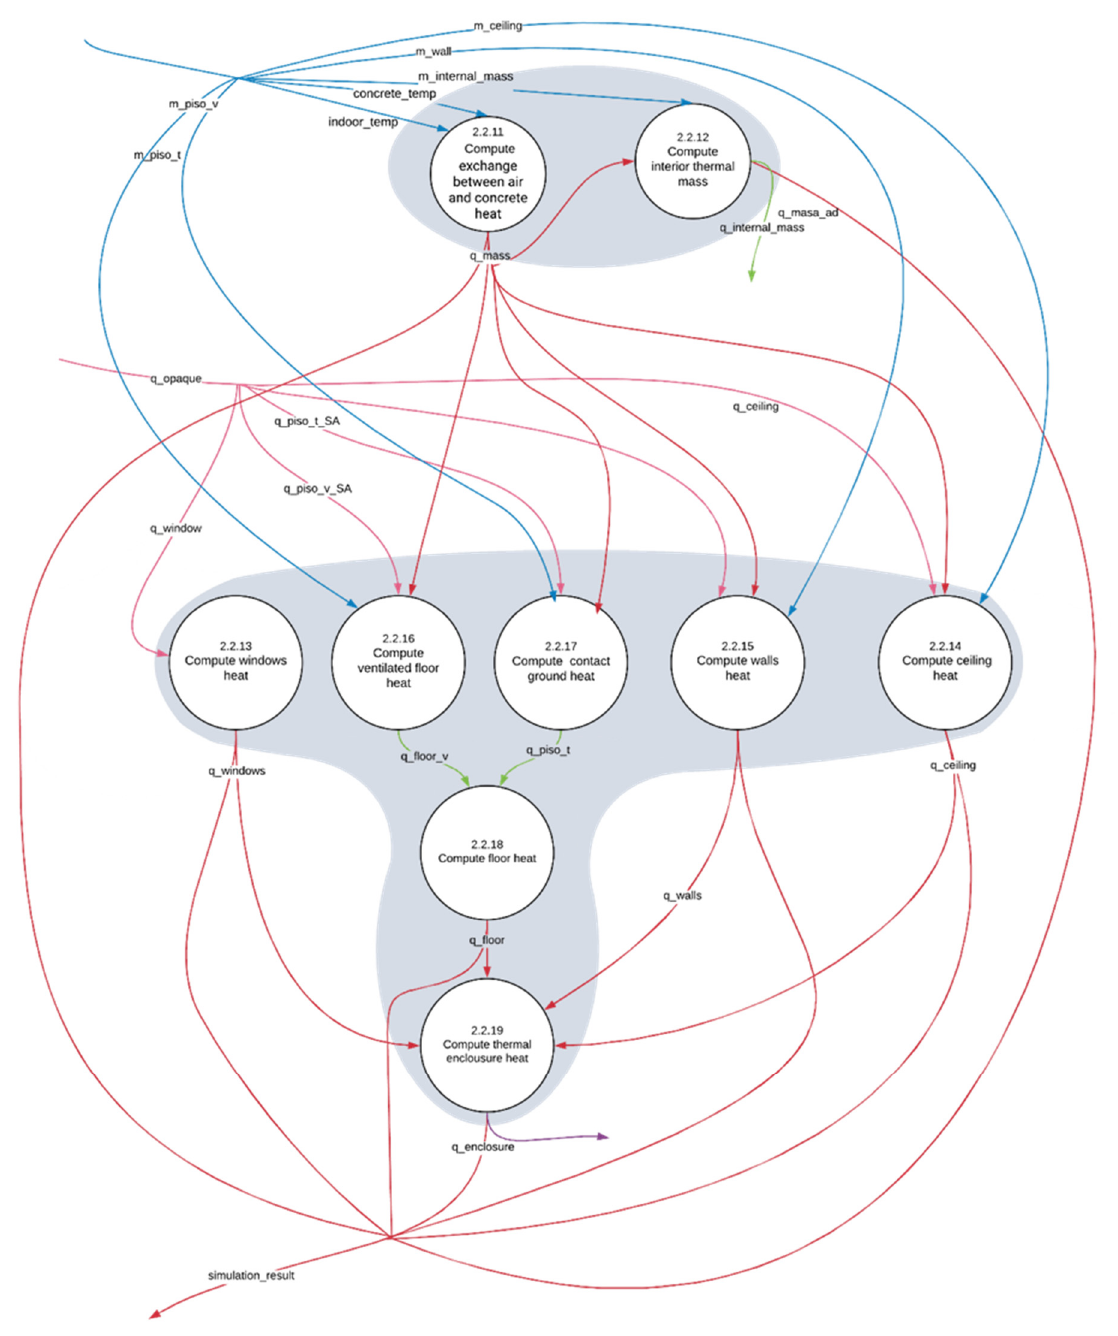
Figure 7. Second step of the energy demand calculation process. Algorithm 8 calculates the heat exchange between the air and the concrete mass, with the purpose of obtaining the heat input from the wall to the interior of the house.